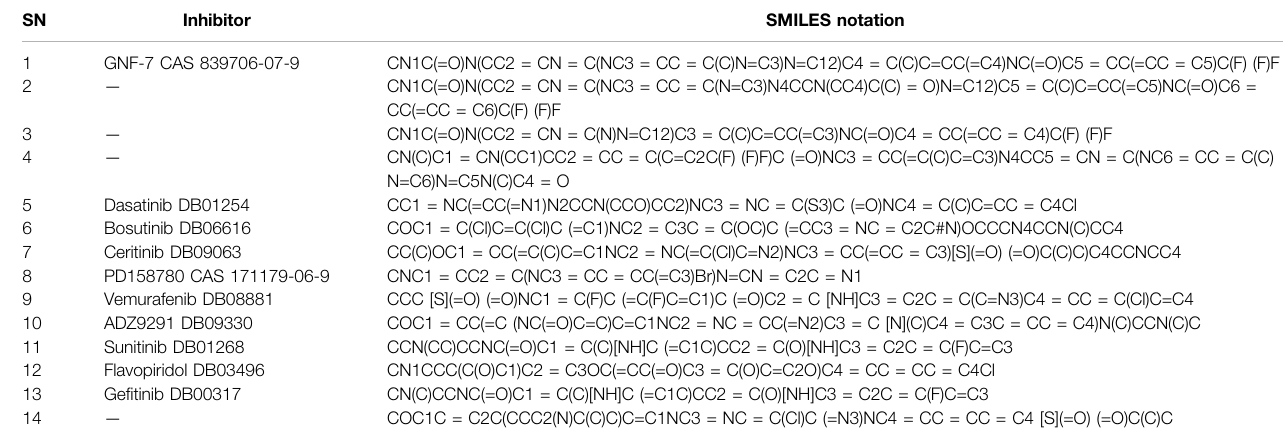
TABLE 1 | Common names, identi fi ers, and simpli fi ed molecular input line entry system (SMILES) notation for 14 multikinase inhibitors. SN Inhibitor SMILES notation